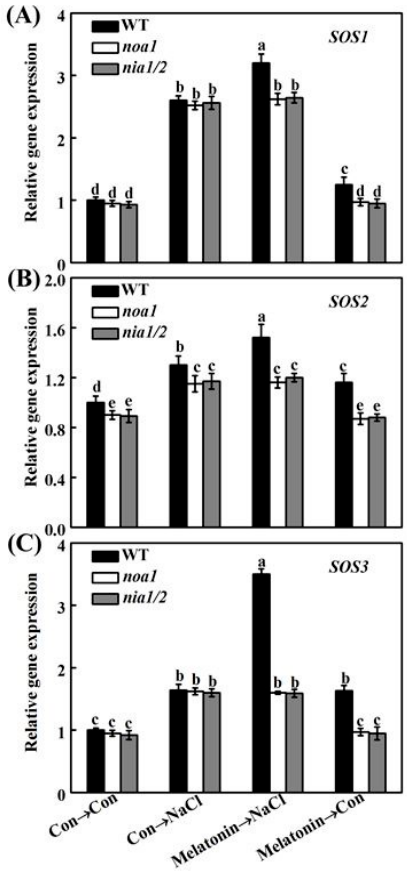
Figure 13. Gene evidence indicated that SOS signaling pathway was regulated by melatonin via NO. Five-day-old wild-type (WT), noa1 , and nia1/2 mutant plants were grown on MS medium supplemented with 1.0 μ M melatonin for 5 days, and then transplanted in medium in the presence or absence of 125 mM NaCl for another 24 h. The mRNA expression of SOS1 ( A ), SOS2 ( B ), and SOS3 ( C ) in root tissues were analyzed by qPCR. Control seedlings (Con) were grown in MS medium alone. Data are means ± SE of three independent experiments with at least three replicates for each. Bars with different letters are significant different at p < 0.05 according to Duncan’s multiple range test.